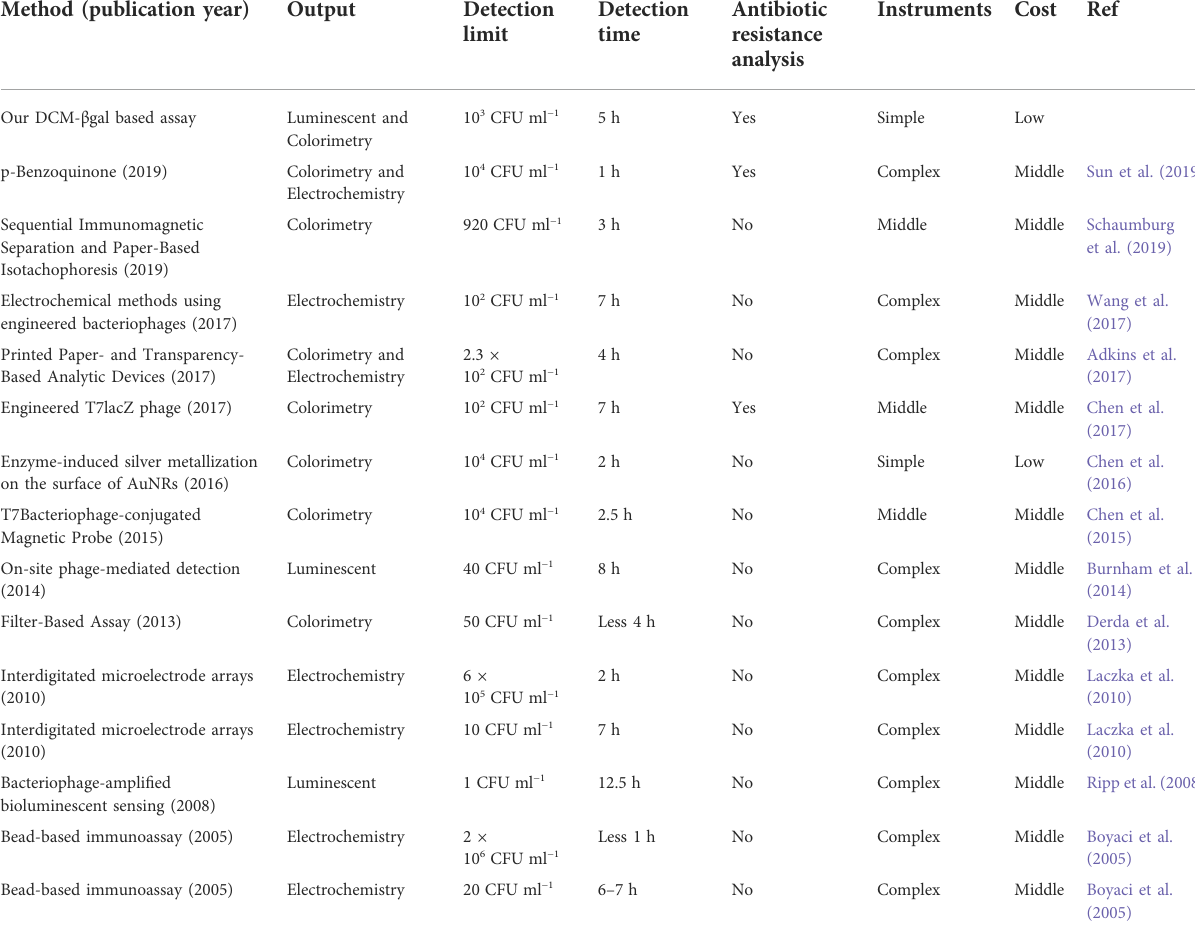
TABLE 1 Summary and comparison of techniques for detection of E. coli